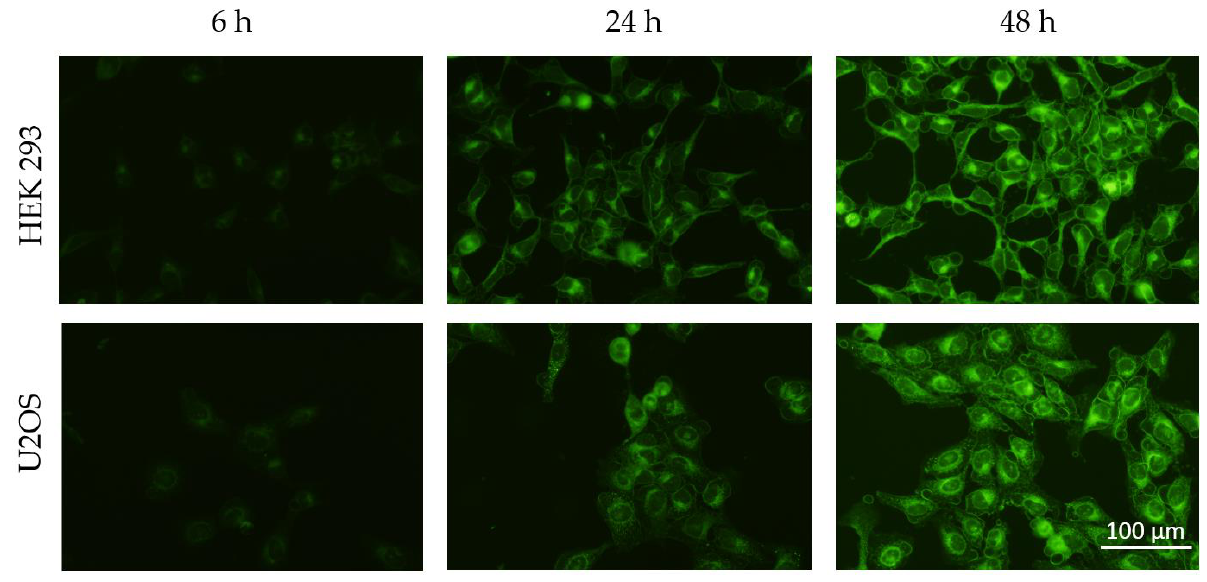
Figure 5. Cellular uptake of SLN-coumarin-6 during 48 h in cell lines HEK 293 and U2OS. Cells were treated with SLN-coumarin-6 and photographed at time points 6 h, 24 h and 48 h. Green fluorescence represents coumarin-6 that entered the cells. Scale bar = 100 µ